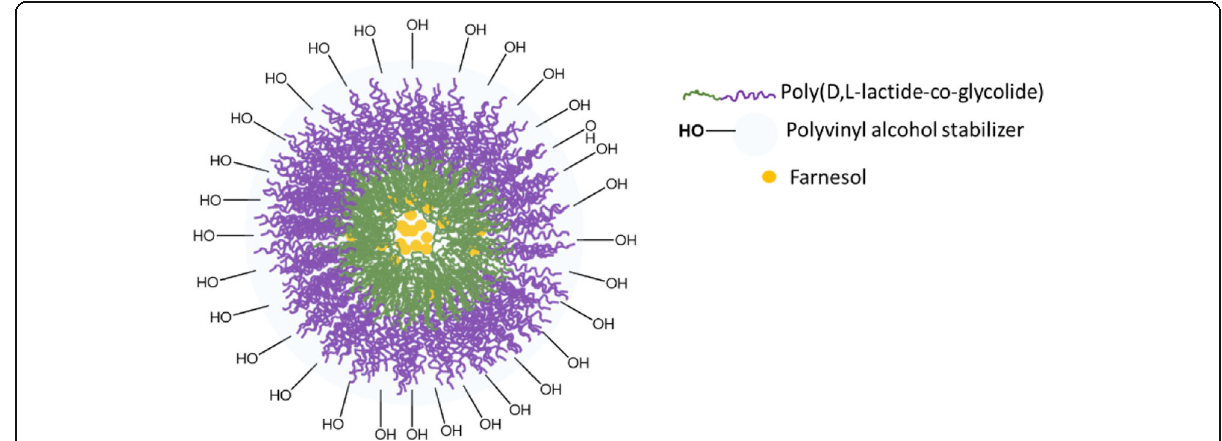
Fig. 1 Schematic illustration of farnesol-loaded particle